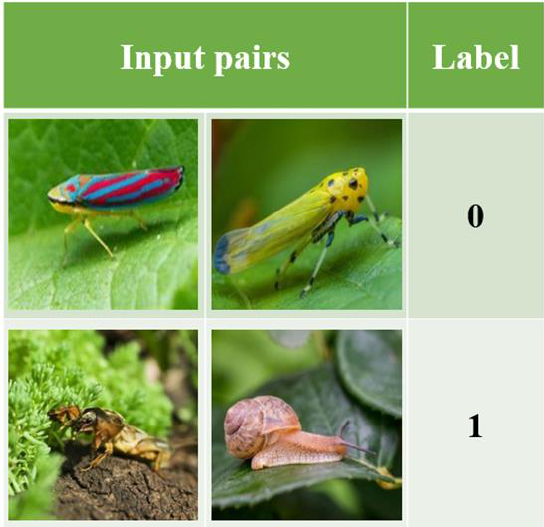
Figure 5. Examples of the input pairs.